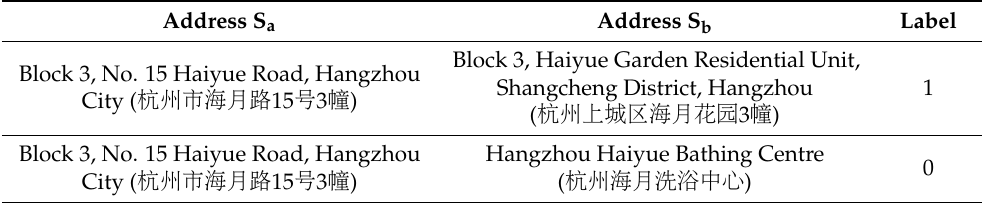
Table 1. Examples of some data in the labelled address dataset.